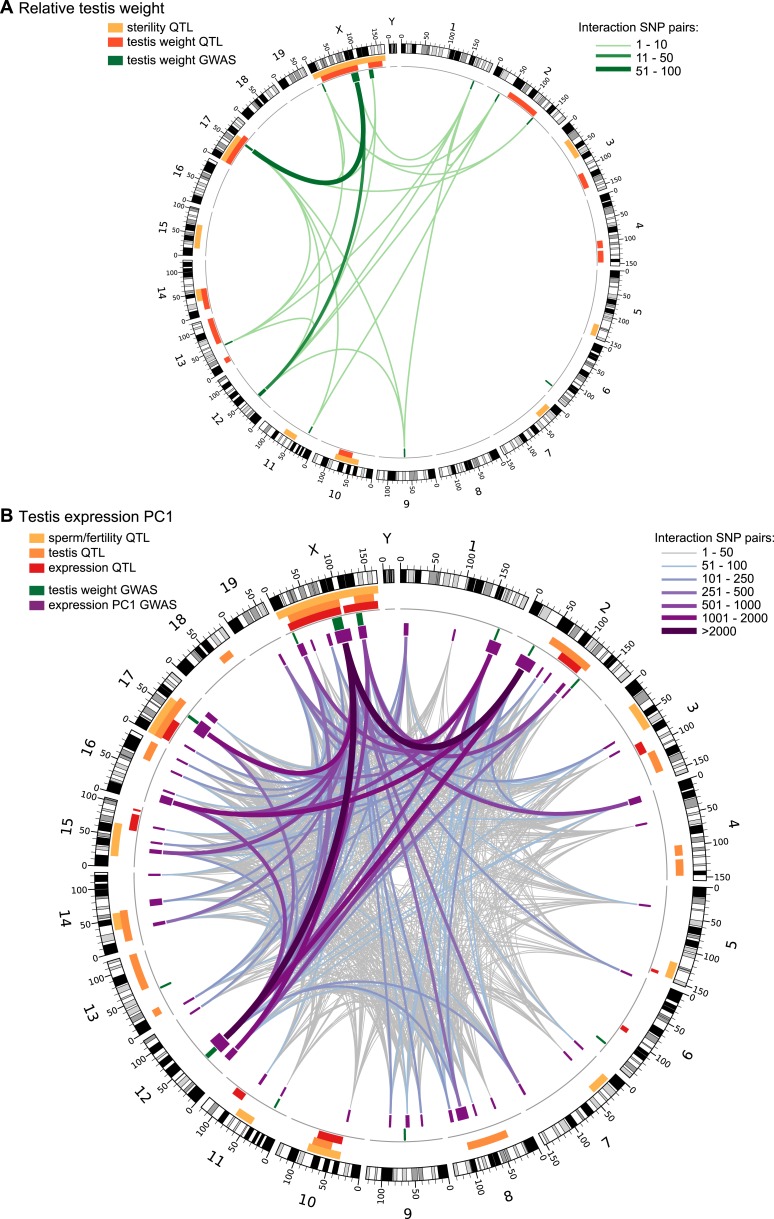
Significant GWAS regions and interactions in hybrid zone mice.Results for (A) relative testis weight and (B) testis expression principal component 1 in hybrid zone mice. In (A) orange and yellow boxes in outer rings (outside grey line) indicate quantitative trait loci (QTL) identified for testis weight and other sterility phenotypes in previous studies (see Table 1 for details). Green boxes indicate significant GWAS regions for relative testis weight. Green lines represent significant genetic interactions between regions; shade and line weight indicate the number of significant pairwise interactions between SNPs for each region pair. In (B) orange boxes in outer rings indicate QTL for testis-related phenotypes (testis weight and seminiferous tubule area) identified in previous studies, yellow boxes indicate QTL for other sterility phenotypes and red boxes indicate trans eQTL hotspots (see Table 2 for details). Green boxes indicate significant GWAS regions for relative testis weight. Purple boxes indicate significant GWAS regions for testis expression PC1. Lines represent significant genetic interactions between regions; color and line weight—as specified in legend—indicate the number of significant pairwise interactions between SNPs for each region pair. Plot generated using circos (Krzywinski et al., 2009).DOI:
http://dx.doi.org/10.7554/eLife.02504.01110.7554/eLife.02504.012Figure 2—source data 1.Significant genetic interactions (SNP pairs) for relative testis weight (excel file).DOI:
http://dx.doi.org/10.7554/eLife.02504.01210.7554/eLife.02504.013Figure 2—source data 2.Significant genetic interactions (SNP pairs) for testis expression PC1 (excel file).